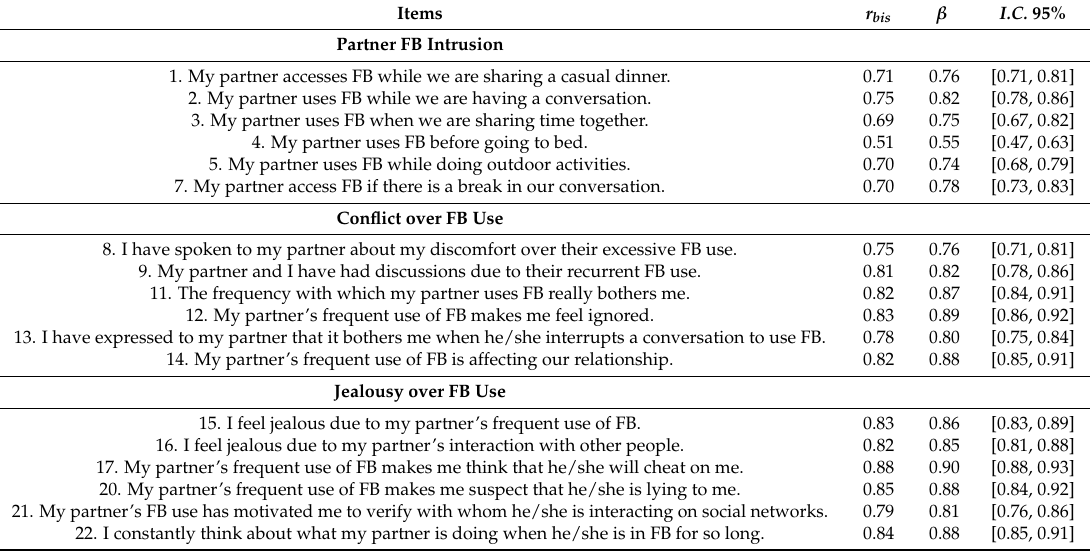
Table 4. Item discrimination indexes, regression coefficients ( β ) on its respective dimensions, and confidence intervals. FB: Facebook.